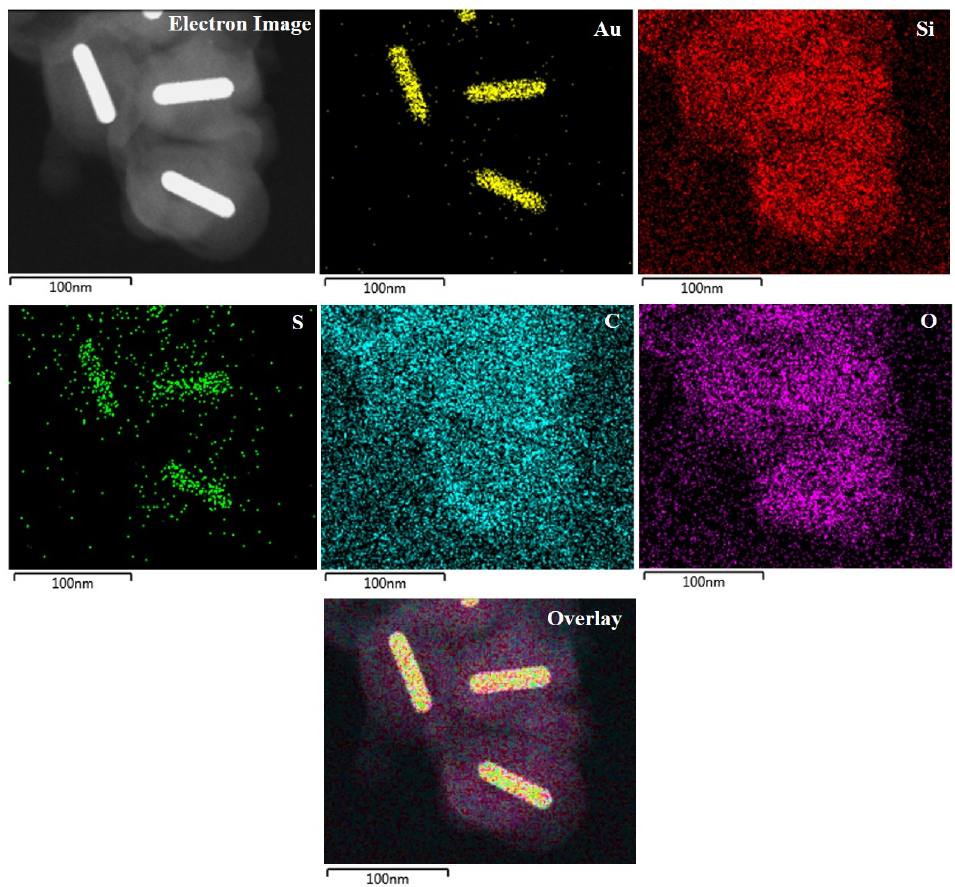
Figure 2. Cs-corrected field emission transmission electron microscope (Cs-corrected FE-TEM) im- age of methylene blue-loaded mesoporous silica-coated gold nanorods on graphene oxide (MB-GNR@mSiO 2